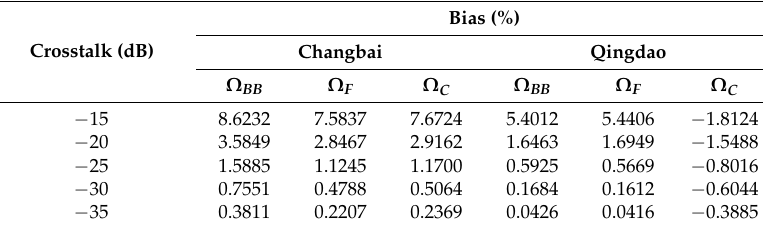
Table 11. Bias ( σ bias ) under the condition of crosstalk.